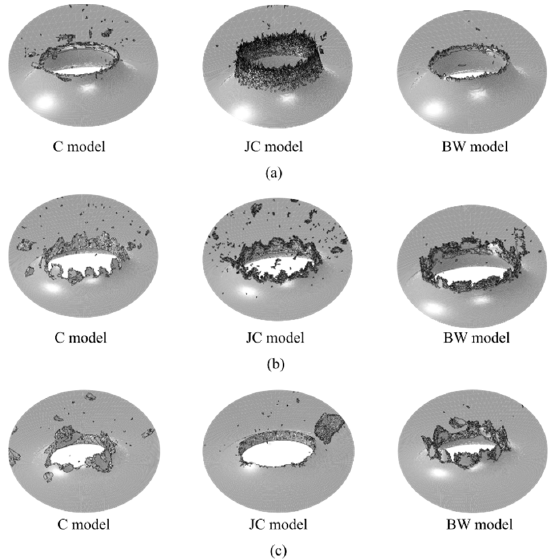
Figure 17. Details of the failure mode of targets impacted by spherical steel projectiles: ( a ) AA 5754 ‐ H111; ( b ) AA 6082 ‐ T6; ( c ) AA 2024 ‐ T351. 5754-H111; ( b ) AA 6082-T6; ( c ) AA